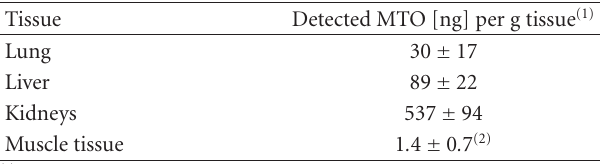
Table 5: Amount of MTO in di ff erent tissues after intravenous application of ferrofluid-bound MTO. New Zealand White rabbits ( n = 5) were treated with 10% of the systemic necessary dose (10mg/ m 2 body